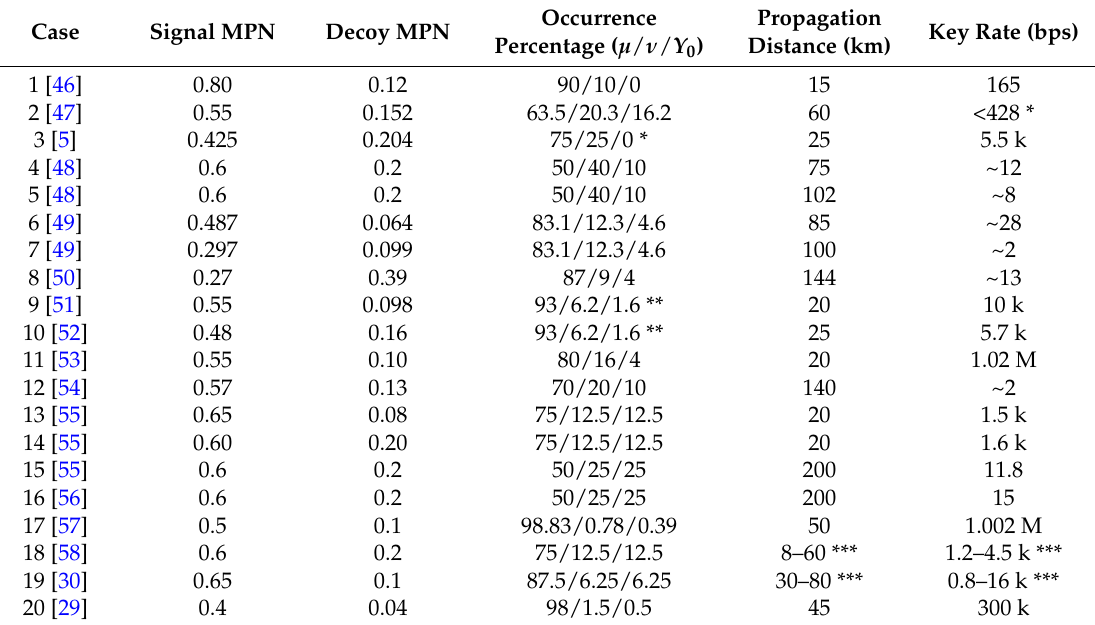
Table 4. Decoy State Enabled QKD System